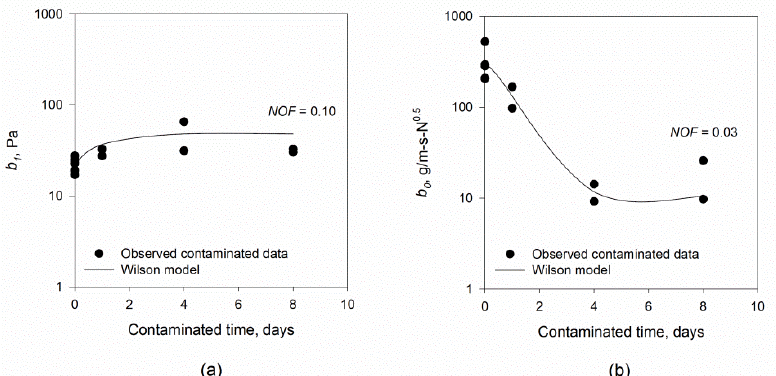
Figure 8. Predicting of Wilson model parameters ( b 1 and b 0 ) of crude oil contaminated soil at different contaminated times (1, 4, and 8) days for small scale at dry soil moisture content: ( a ) parameter b 1 and ( b ) parameter b 0 .